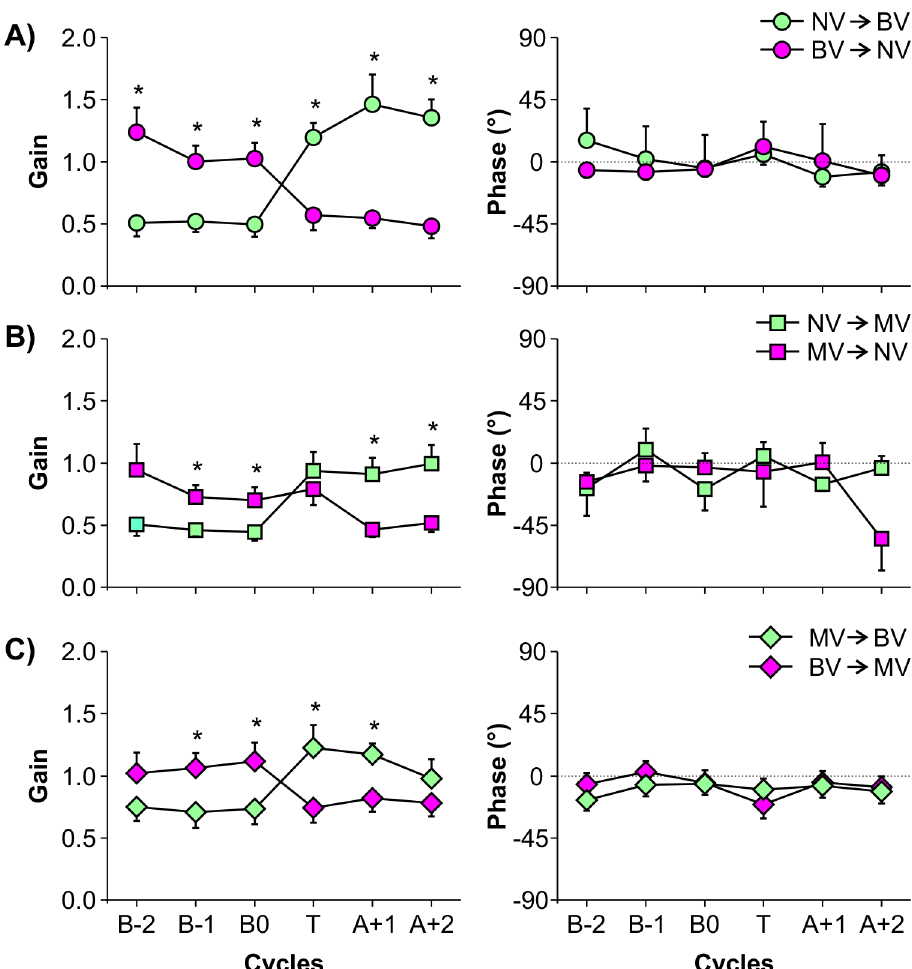
Fig 4. Cycle-by-cycle gain (left column) and phase (right column) mean and standard error values for the combined visual transitions. A) Binocular and no vision transitions. B) Monocular and no vision transitions. C) Binocular and monocular vision transitions. Asterisks indicate pairwise differences between visual conditions ( * p (cid:3) 0.05) [BV: binocular vision | NV: no vision | MV: monocular